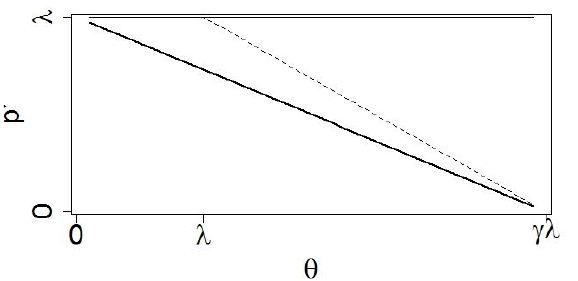
Figure 1. Shape of first derivate of the penalty functions ( for the LASSO (horizontal line, top), SCAD (dashed line) and MCP.